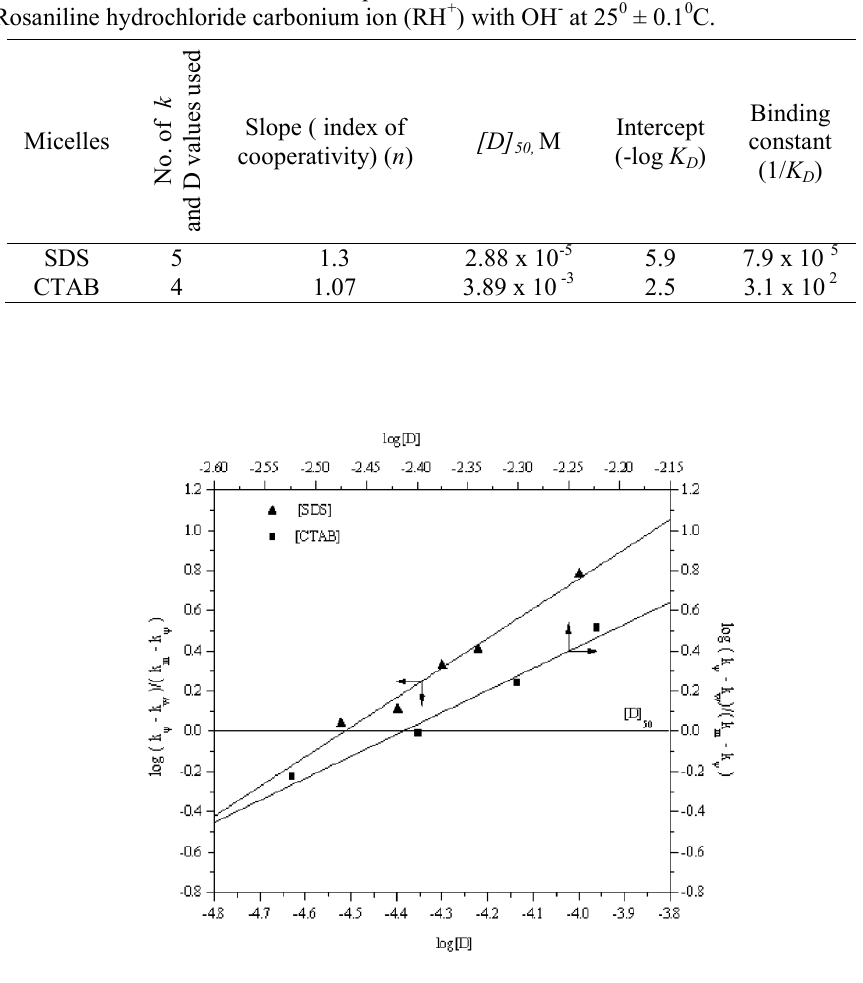
Table 1. Piszkiewicz’s model derived parameters for CTAB and SDS influenced reactions of Rosaniline hydrochloride carbonium ion (RH + ) with OH - at 25 0 ± 0.1 0 C.